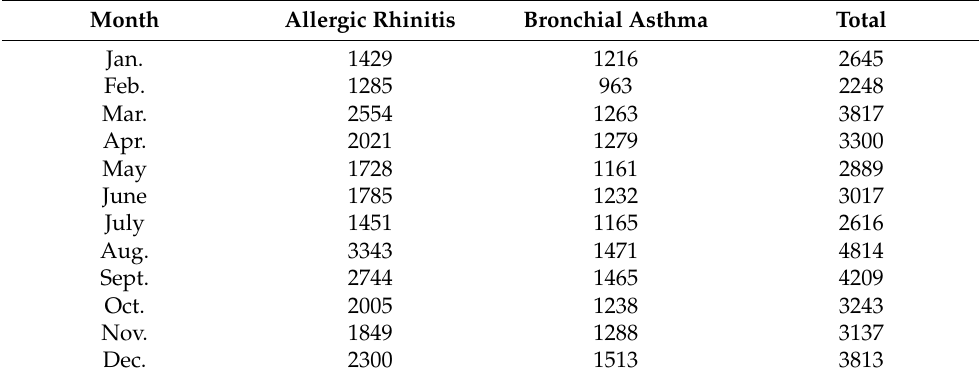
Table A2. Diagnosis data of pollen allergies in spring in Beijing in 2015